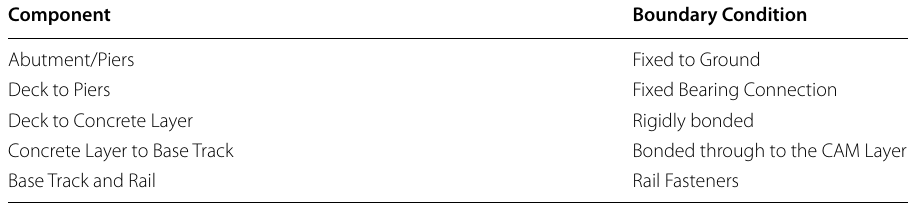
Table 3 Boundary Condition